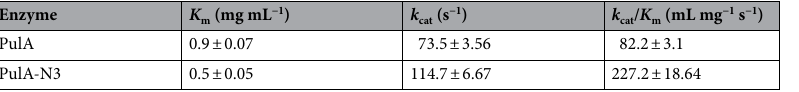
Table 3. Kinetic parameters (mean ± standard deviation of triplicate experiments) of pullulanase PulA-N3.